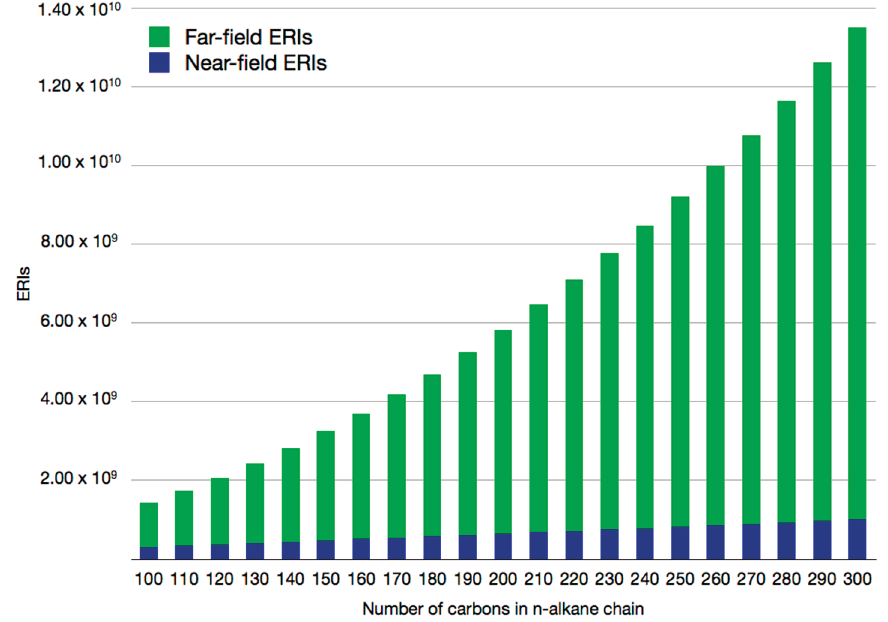
Figure 3. Number of near-field and far-field ERIs in selected n -alkane chains.